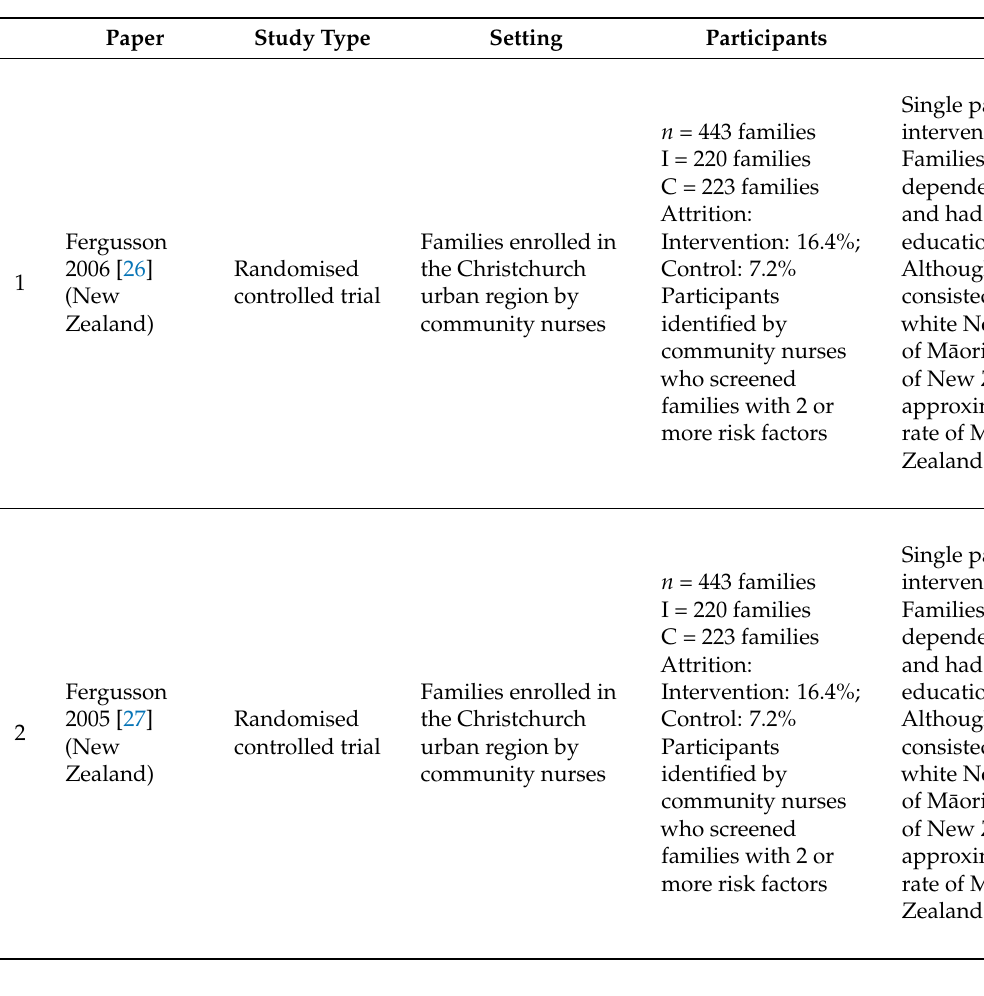
Table 1. Description of Included